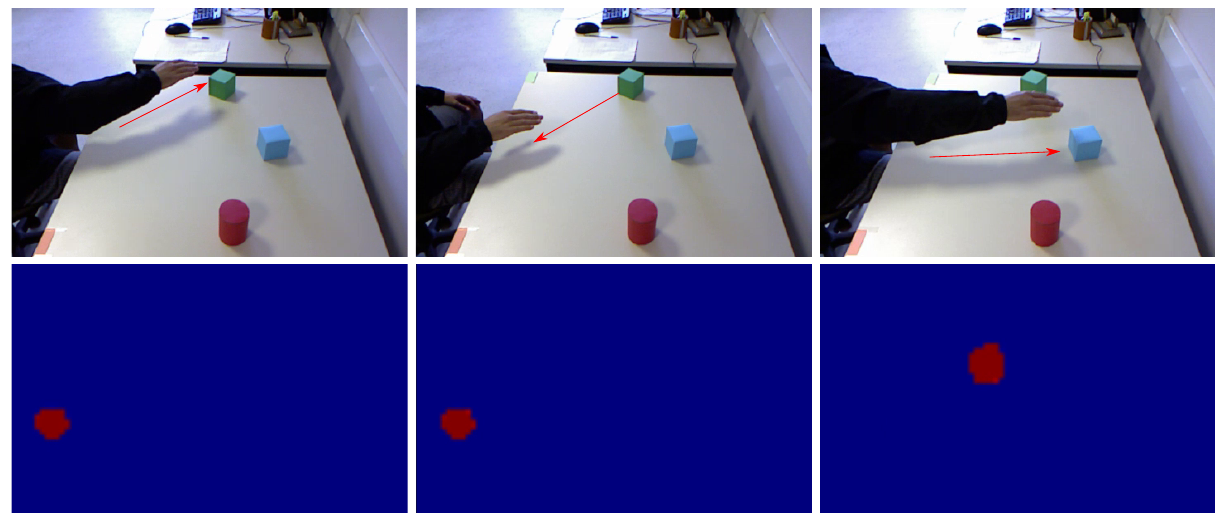
Figure 5: Object selection: Movement toward the green object (left column) triggers the selection of this object as the target. Movement away from the green object (center column) also triggers the selection of this object. Movement toward the blue object (right column) trig- gers selection of the blue object as